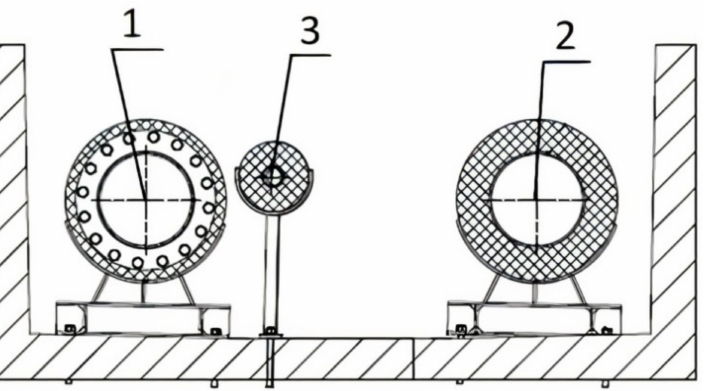
Figure 7. Cross section through the freezing channel (A-A): 1—inlet pipe, 2—outlet pipe, 3—vent pipe.